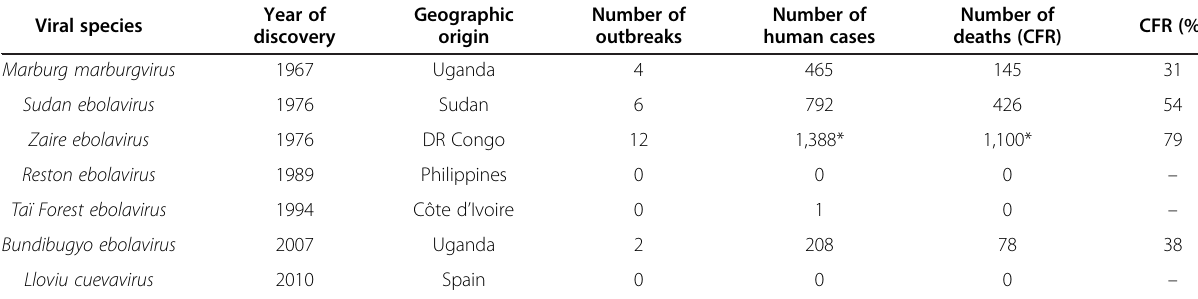
Table 1 Filoviridae virus occurrences in the world